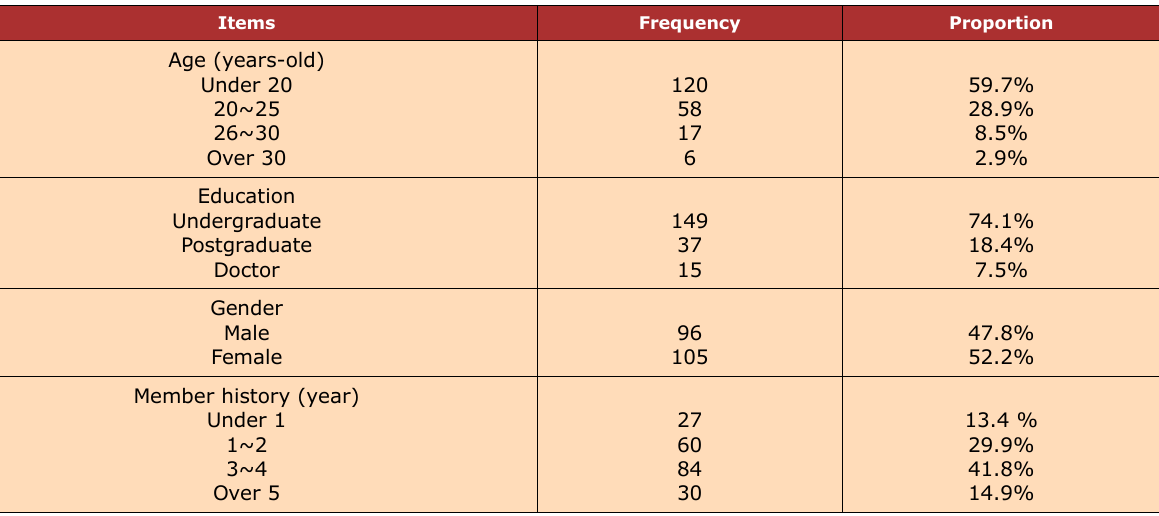
Table 1. Samples of the